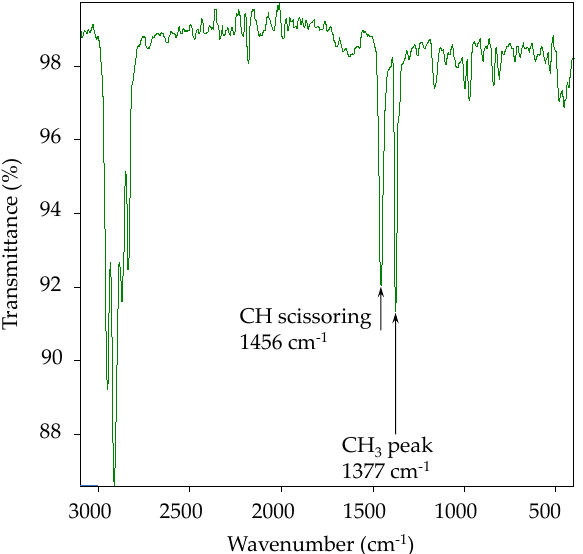
Figure 7. FTIR spectrum of a particle collected from the NZ green-lipped mussel digestive tract identified as PP.